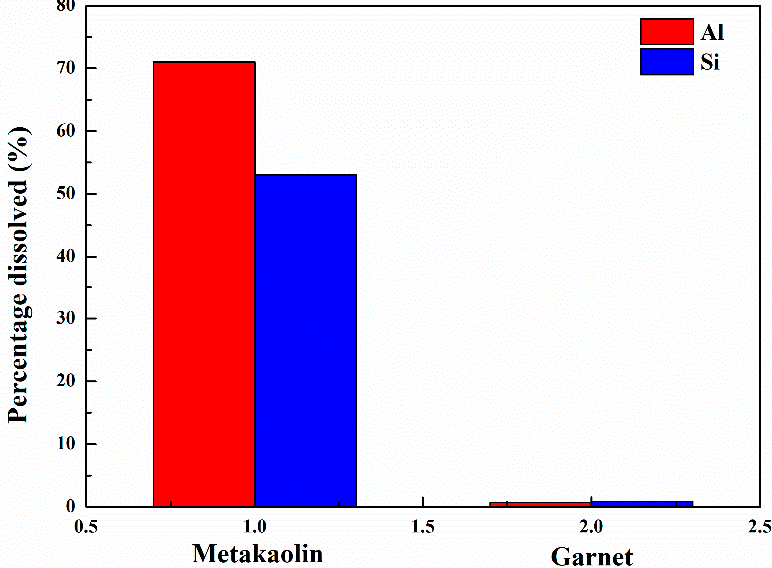
Figure 3. The dissolution efficiency of Al 2 O 3 and SiO 2 in the alkaline media test of raw garnet tailing and metakaolin.